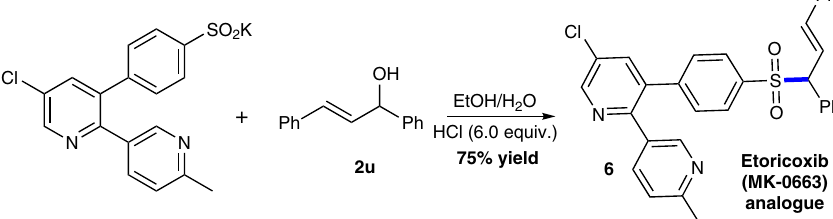
Fig. 5 Preparation of Etoricoxib (MK-0663) analog. HCl hydrochloric acid (HCl, 37%). This reaction performed at 30 °C for 72